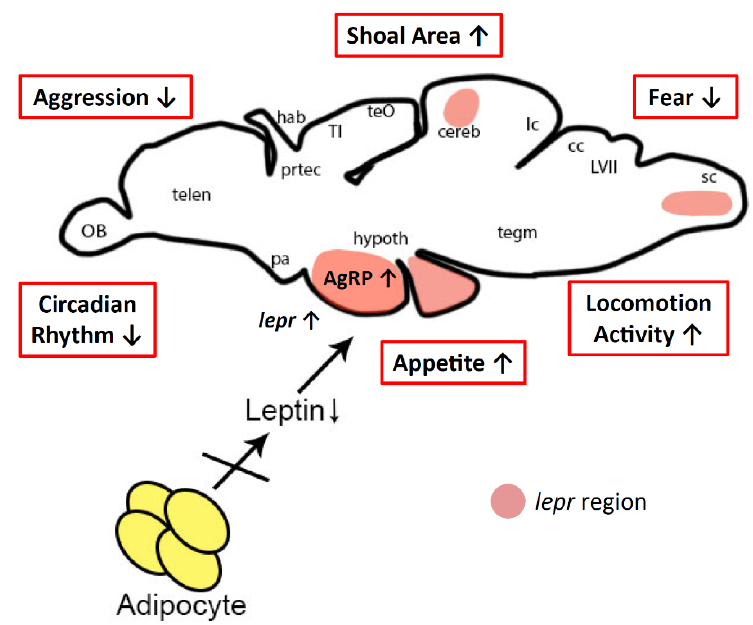
Figure 7. Proposed mechanism of leptin deficiency that affected on zebrafish behaviors. Leptin production by adipocyte is greatly reduced in lepa -deficient fish. Reduction of leptin induces the lepr overshooting in some specific regions on the zebrafish brain. Lack of leptin affects behavioral changes by deregulating HPA-axis and/or medulla oblongata functions resulting in dysregulated circadian rhythm, shoal formation, fear, and aggression, also increment of locomotion activity. Leptin deficiency also increases AgRP level, producing high level of appetite. OB, olfactory bulb; Telen, Telecephalon; TeO, Tectum Opticum; Hab, Habenula; Hypoth, Hypothalamus; SC, Spinal cord; Prtec, Pretectal population; Cc, Crista Cerebellaris; LVII, facial lobe; Tegm, tegmentum; Pa, Preoptic area; TI, Torus longitudinalis; Lc, Lobus caudalis.